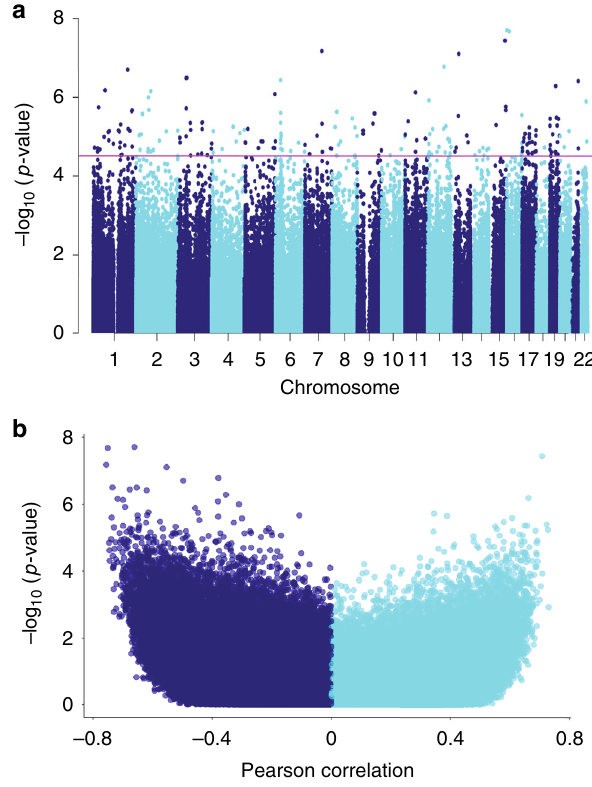
Fig. 1 Association between cytosine methylation changes and interstitial fi brosis. a Manhattan plot of Interstitial Fibrosis associated methylation changes. The x -axis represents the genomic location of the probe, while the y -axis is the negative base 10 log of the p -value. (The association between the methylation level of 321,473 probes and kidney fi brosis was studied using a linear regression models adjusted for age, gender, race, diabetes, hypertension, batch, bisul fi te conversion, and degree of lymphocytic in fi ltrate on histology. The threshold for genome-wide signi fi cance was set at p -value FDR < 0.05 as indicated by the horizontal magenta line). b Volcano plot depicting the association between Interstitial Fibrosis and methylation changes. The x -axis represents the Pearson correlation coef fi cient of each probe with Interstitial Fibrosis. The y -axis is the negative base 10 log of the p -value each probe associated with Interstitial Fibrosis